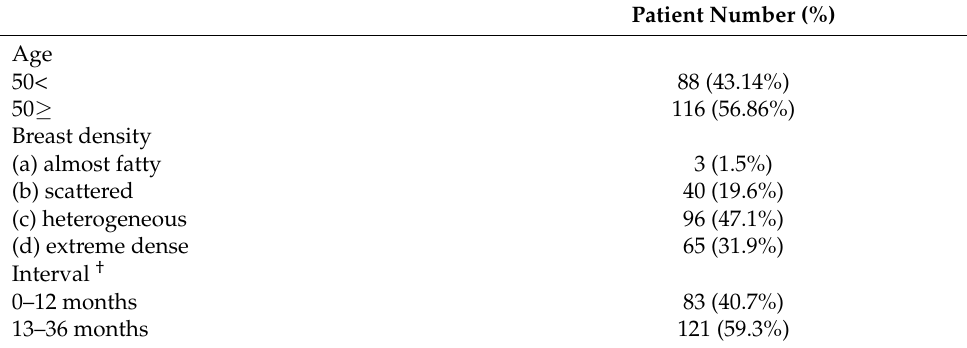
Table 1. Baseline patient characteristics.